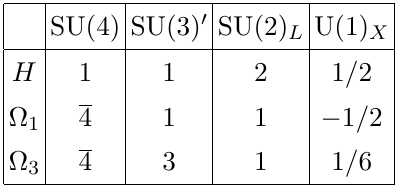
Table 1 . Scalar content of the 4321